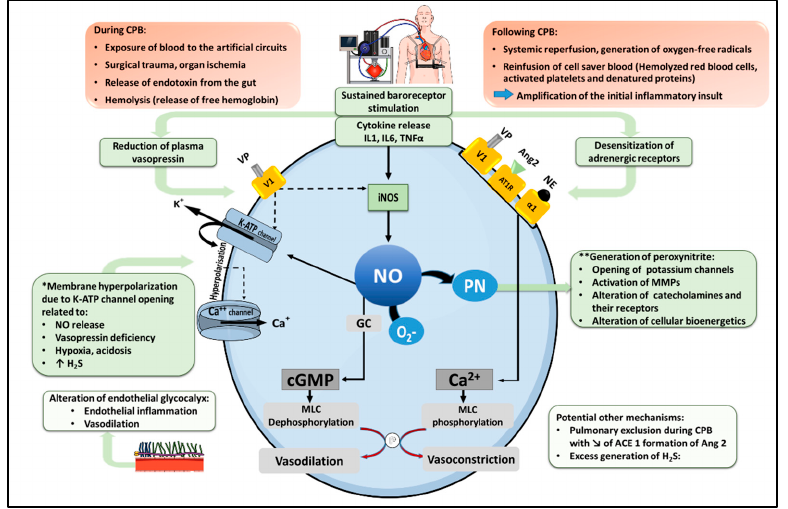
Figure 1. Pathophysiological mechanism of vasoplegia after cardio-pulmonary bypass. Under nor- mal conditions, norepinephrine (NE), angiotensin 2 (Ang2) and vasopressin (VP) activate their re- spective receptors in vascular smooth muscle cells, namely the α 1-adrenoreceptor, the Ang2 type I receptor (AT1R) and the vasopressin V1 receptor, to promote an increase in cytosolic Ca ++ , leading to Myosin Light Chain (MLC) phosphorylation, actin-myosin interaction and smooth muscle con- traction. In addition, vasopressin exerts indirect vasoconstrictor actions by inhibiting two physio- logical mechanisms of vasodilation, including NO production and the opening of ATP-dependent potassium channels (K ATP ). Following cardiopulmonary bypass (CPB), cytokine release and sus- tained baroreceptor stimulation foster a down-regulation and desensitization of adrenergic recep- tors, as well as a reduction in plasma VP, reducing catecholamine and vasopressin-mediated vaso- constriction. In addition, inflammatory cytokines stimulate the expression of the inducible isoform of NO synthase (iNOS), leading to excessive NO production. NO activates soluble guanylyl cyclase (GC), generating cyclic GMP (cGMP), which dephosphorylates MLC with subsequent vasodilation. Moreover, NO activates K ATP channels, causing K + efflux, membrane hyperpolarization, and the clo- sure of Ca ++ channels, thereby reduce cytosolic Ca ++ . K ATP channels opening and membrane hyperpo- larization can also result from additional mechanisms, as indicated (*). NO further reacts with the superoxide anion radical (O 2 − ) to form peroxynitrite (PN), which contributes to vasodilation via multiple processes, as indicated (**). CPB can also trigger alterations of the glycocalyx (favoring endothelial dysfunction and vascular inflammation), promote the production of hydrogen sulfide (H 2 S) with vasodilating properties, and reduce Ang2 formation by type I angiotensin-converting enzyme (ACE 1). Solid lines indicate activation; dashed lines indicate inhibition. 2.2. Inflammatory Pathways Triggered by CPB Several mechanisms triggered at the time of CPB, and amplified upon its discontin- uation, concur to trigger a systemic inflammatory response: the exposure of blood com- ponents to the artificial surfaces of the extracorporeal circuit, surgical trauma, organ is- chemia, the release of endotoxin from the gut into the circulation, and hemolysis with liberation of free hemoglobin. Altogether, these mechanisms promote the activation of the complement cascade and the expression of pro-inflammatory mediators, such as interleu- kin-1 beta (IL-1 β ), interleukin-6 (IL-6) and tumor necrosis factor alpha (TNF α ) [6,19,20]. IL-6 is notably a potent inhibitor of vascular contraction by increasing the synthesis of cyclic AMP, which promotes vasodilation by reducing myoplasmic [Ca ++ ] [21,22]. Accord- ingly, higher circulating levels of IL-6 have been associated with an increased incidence of VS and a higher need for vasopressors after CPB [23,24]. Longer CPB and aortic cross- clamping durations, combined surgery and redo intervention all predispose to a more